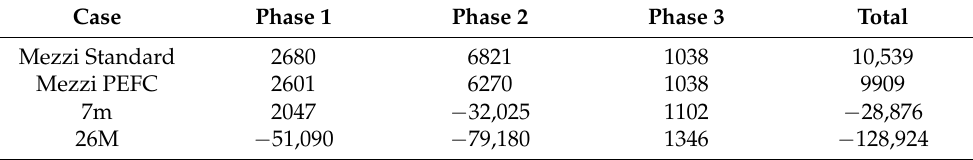
Table 2. IPCC 2013 GWP for a time frame of 100 years expressed as Kg of CO 2